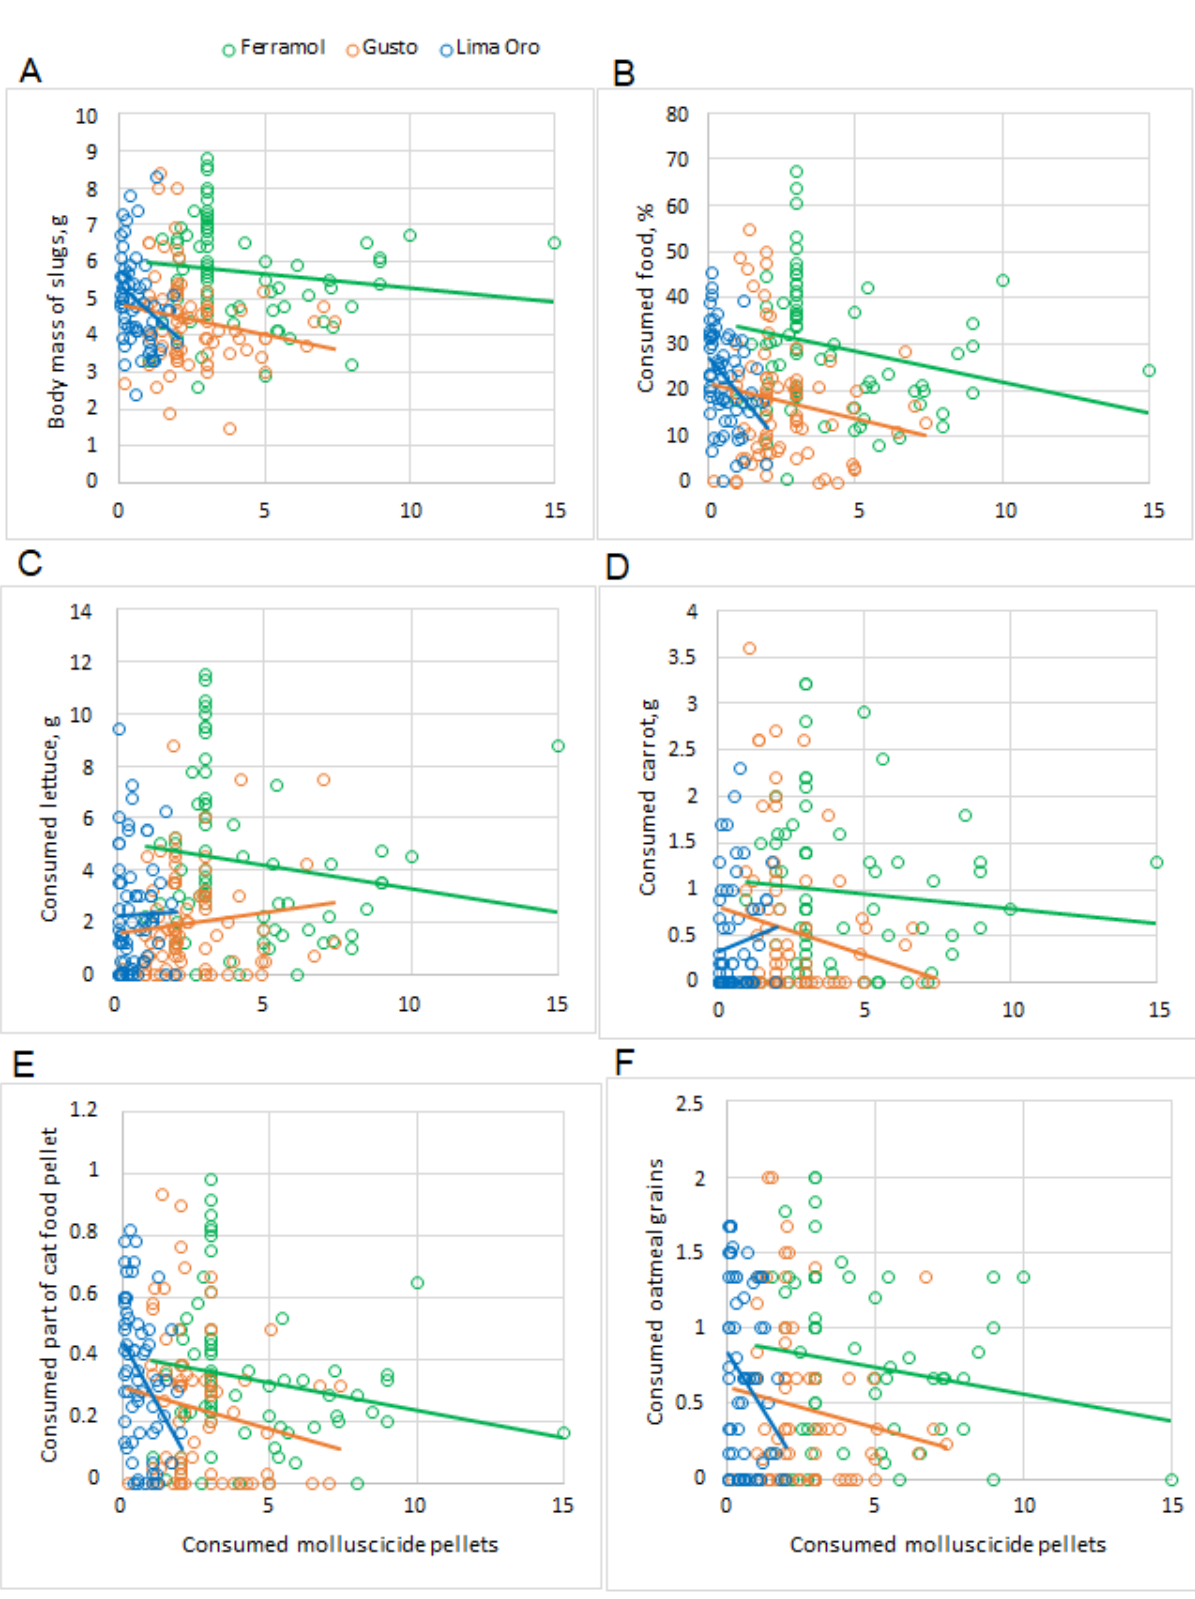
Figure 4. Body mass and food consumption of slugs after the 7-day treatment (for both designs) plotted with trend lines against the number of molluscicide pellets consumed: ( A ) body mass, g; ( B ) all food, %; ( C ) lettuce, g; ( D ) carrot, g; ( E ) number (or part) of cat food pellets; ( F ) number (or part) of oatmeal grains.